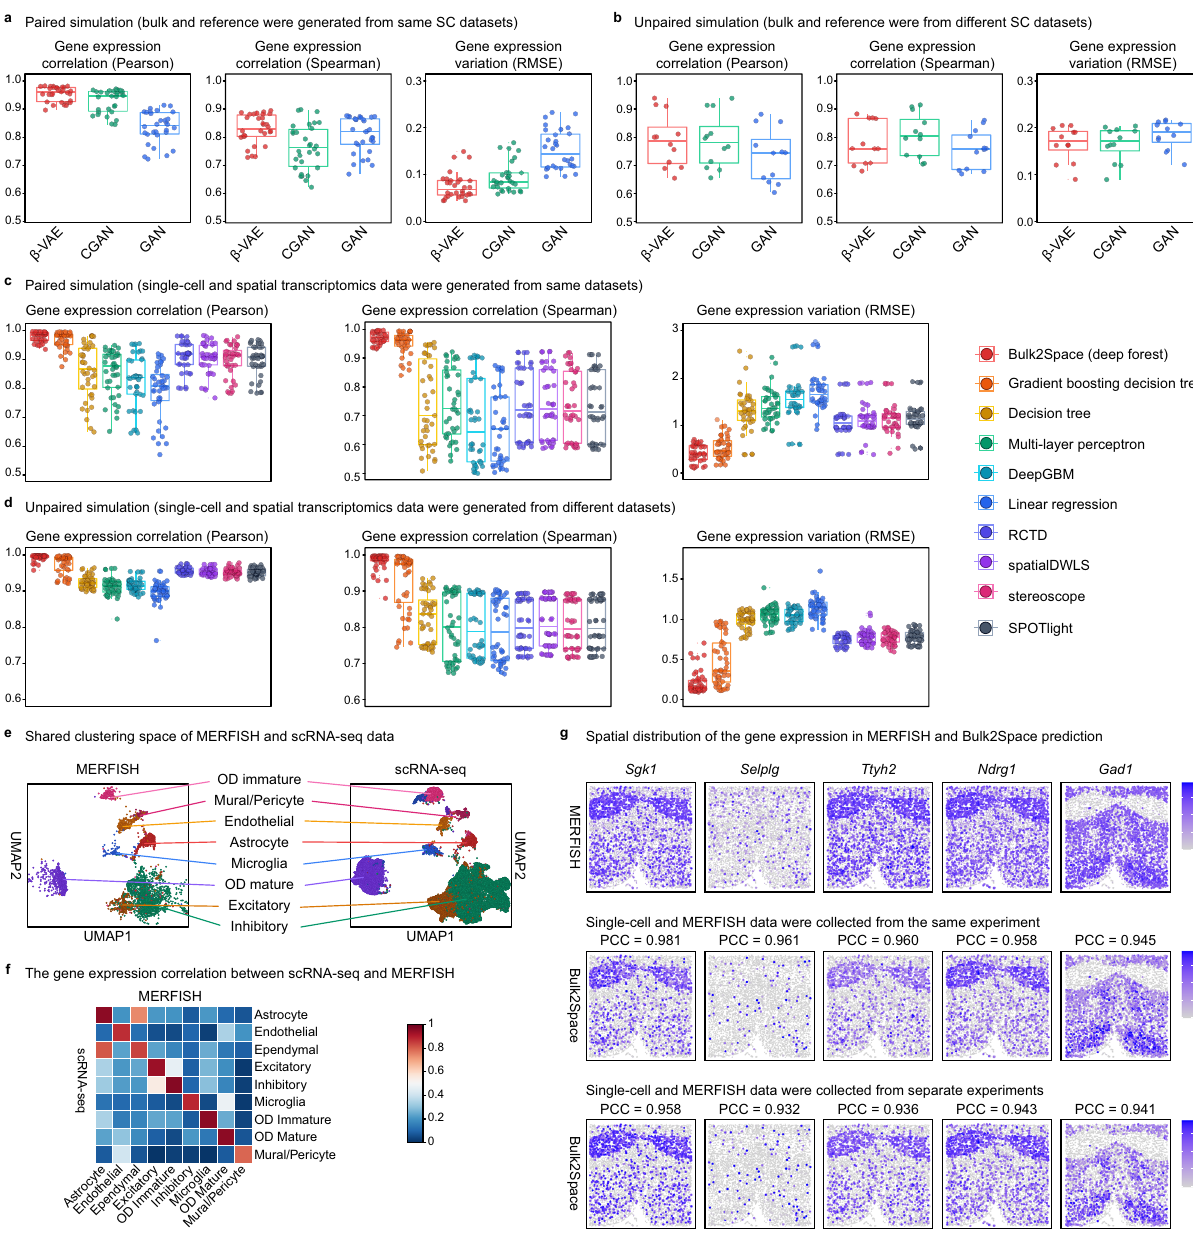
median,75thpercentile,andmaxima).Left,Pearsoncorrelationofgeneexpression, Middle,Spearmancorrelationofgeneexpression,Right,geneexpressionvariation (RMSE). d Benchmarktest for10 spatialmapping methodsusing paired simulation data ( n = 60). Data are presented as boxplots (minima, 25th percentile, median, 75th percentile, and maxima). e The UMAP layout of the MERFISH data (image- based spatially resolved transcriptomics) and the single-cell data. Share cell types were colored with corresponding colors. f Expression correlation heatmap of the markergenesofallsharedcelltypesinMERFISHdataandscRNA-seqdata. g Spatial expression ofgenesinthe ground truth and predicted by Bulk2Space using paired and unpaired single-cell RNA-seq data. PCC for each gene was shown. Source data are provided as a Source Data fi le.